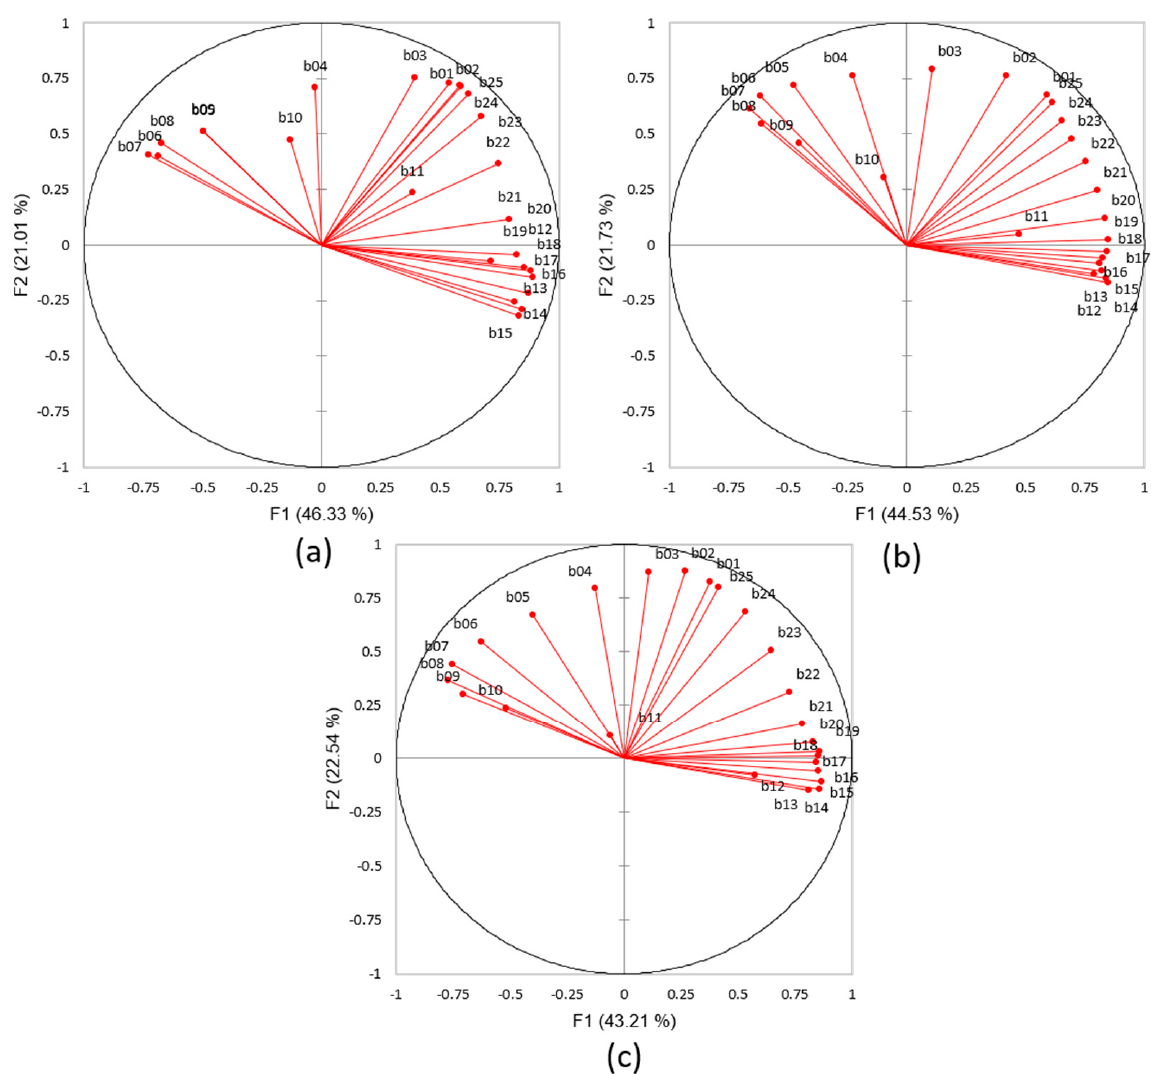
Figure 4. Principal Component Analysis (PCA) biplot for each year with the distribution of the 25 NDVI temporal bands (red vectors) according to the first two PCA axis: ( a ) 2017; ( b ) 2018; ( c ) 2019.